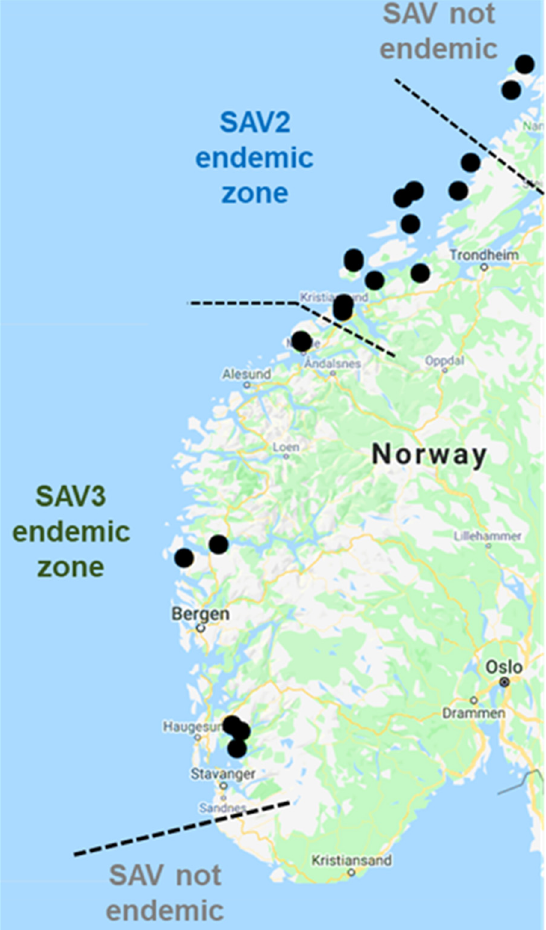
Figure 1. Sampling locations mapped against the current definition of SAV endemic zones.